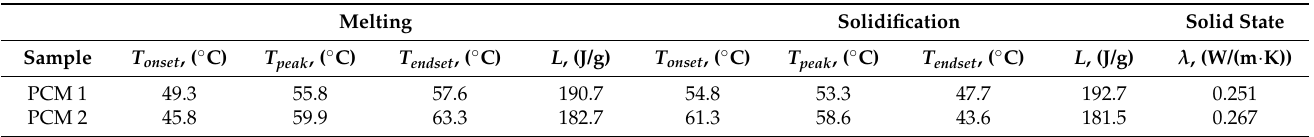
Table 5. Thermal properties of the investigated